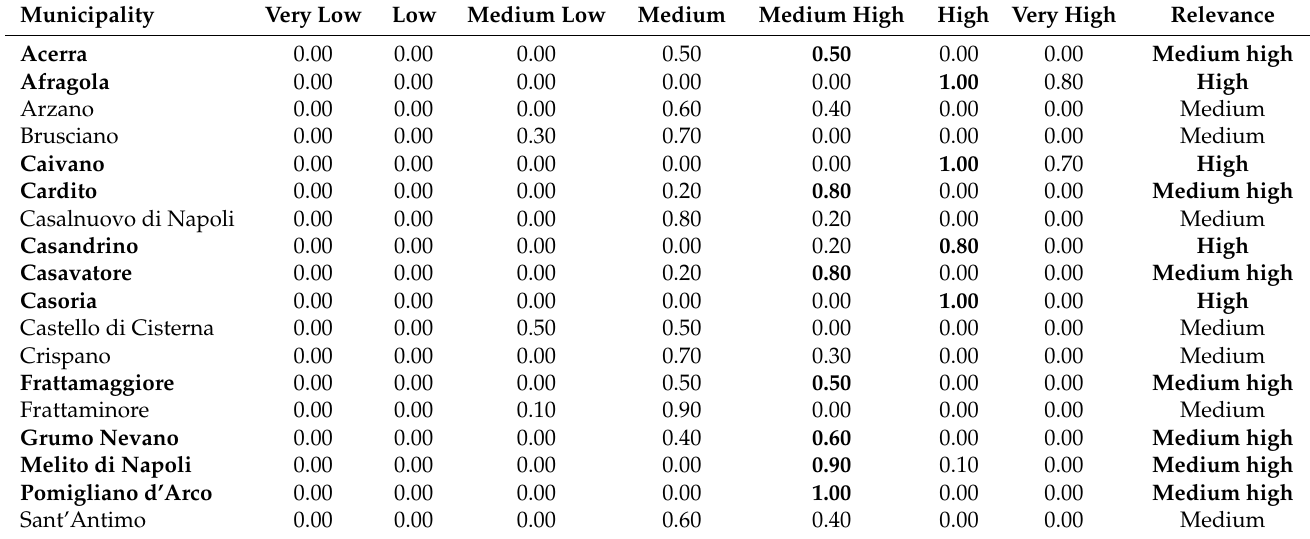
Table 7. Relevance of unpleasant emotional categories in